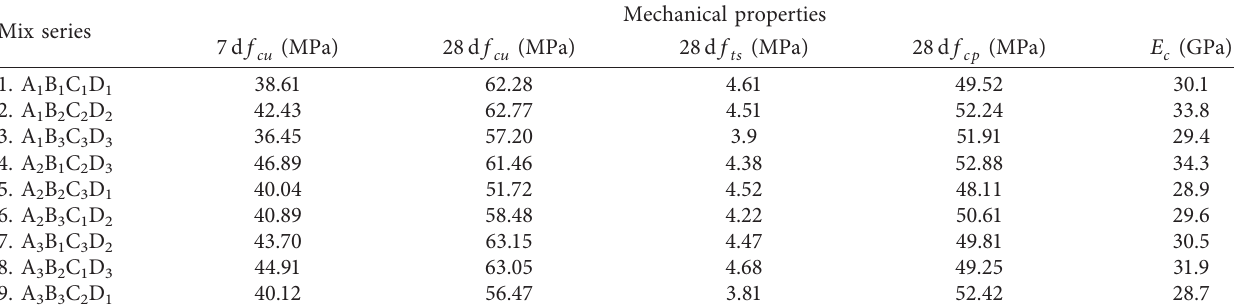
Table 11: Mechanical properties test results.